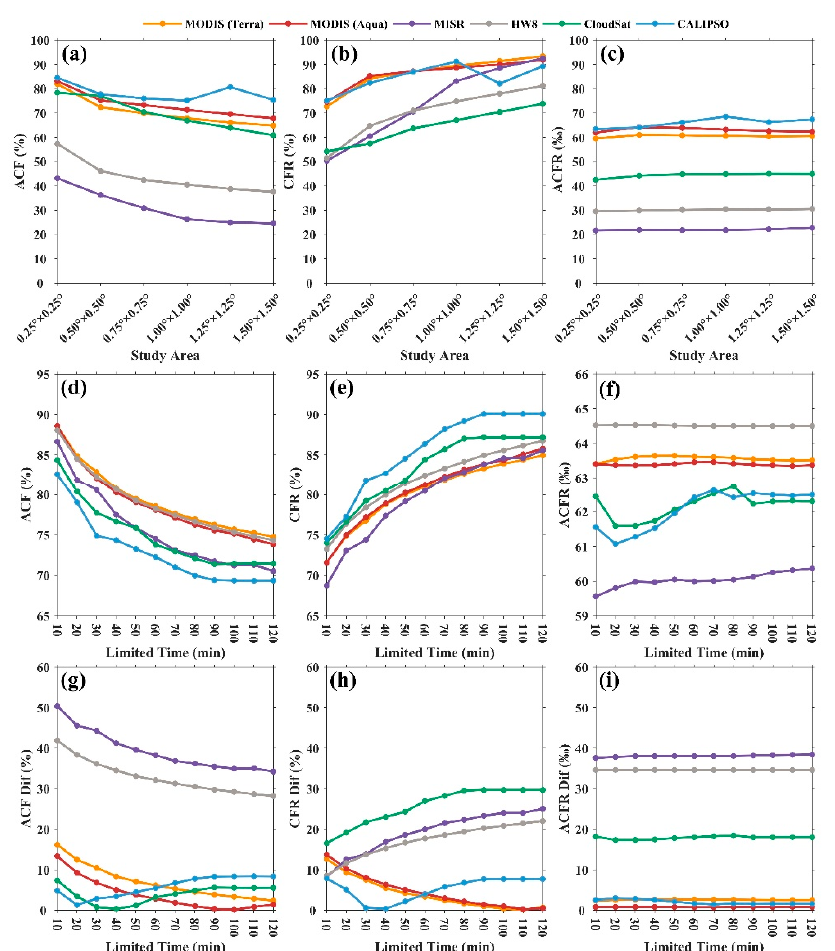
Figure 2. Variations of satellite ( a ) average cloud fraction (ACF), ( b ) cloud frequency (CFR), and ( c ) average cloud fraction × cloud frequency (ACFR) over different spatial boxes center at SACOL site (from 0.25° × 0.25° to 1.5° × 1.5° with an interval of 0.25°); dependence of ( d ) ACF, ( e ) CFR, and ( f ) ACFR on different KAZR observation time intervals; the absolute difference of ( g ) ACF, ( h ) CFR, and ( i ) ACFR between satellite observations within 0.5° × 0.5° box area and KAZR at different time intervals.